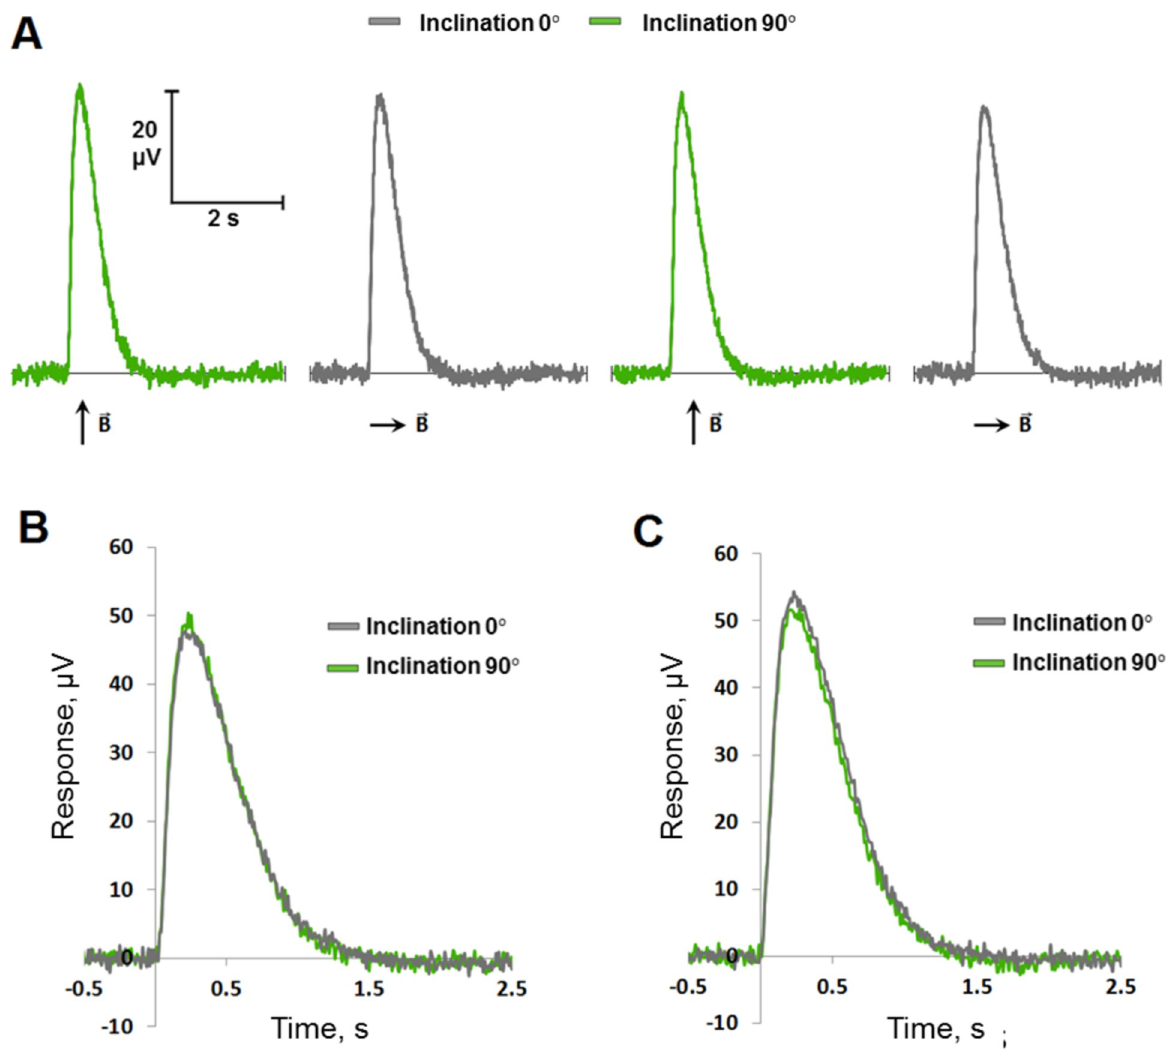
Fig 3. Effect of the MF inclination on photoreceptor responses from the isolated pigeon retina. (A) Series of four average photoreceptor responses to half-saturating blue flashes (10 ms, intensity 2.1 × 10 8 photons/mm 2 ) recorded one after another with changing of MF inclination (90˚ ! 0˚ ! 90˚ ! 0˚). (B) Two average photoreceptor responses to half-saturating blue flashes (10 ms, intensity 2.1 × 10 8 photons/mm 2 ) at different MF inclinations. (C) Same for two average responses to half-saturating red flashes (10 ms, intensity 1.8 × 10 10 photons/mm 2 ).